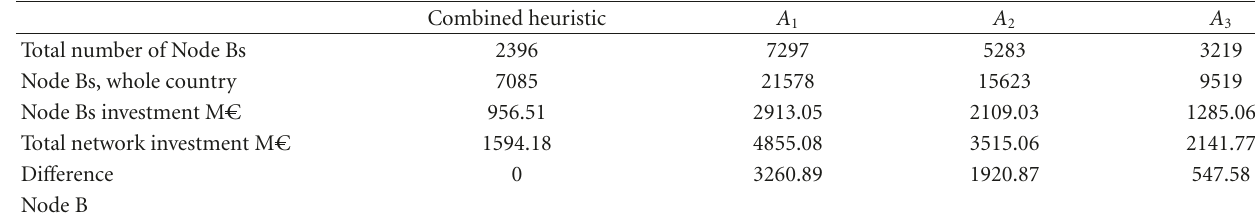
Table 16: Load factors in the